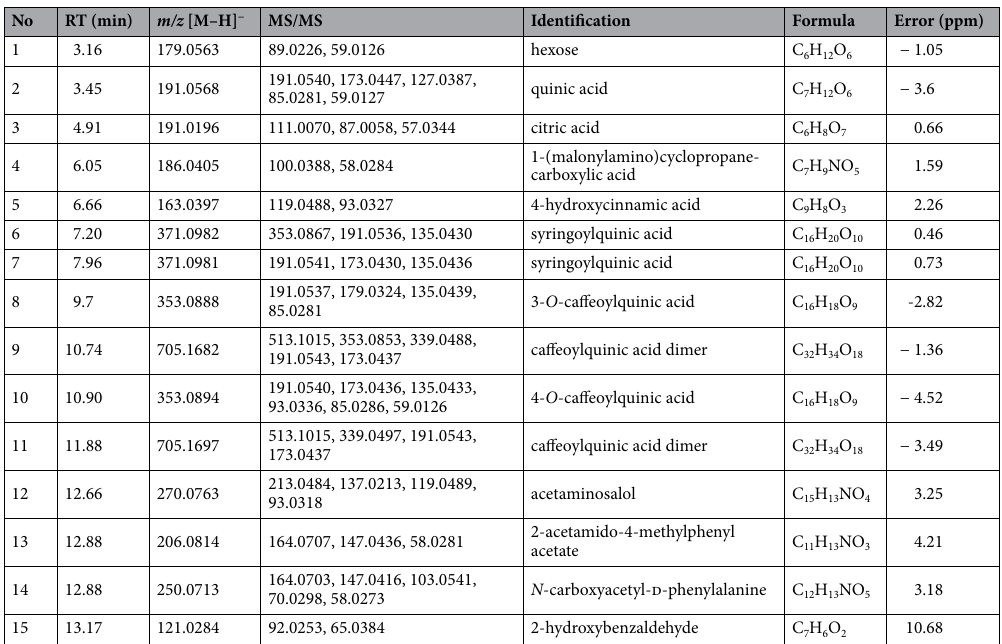
Figure 1. Total ion chromatogram of F. dubia sap extract at a concentration of 20 mg/mL operated in negative ionization mode ( A ) and positive ionization mode ( B ). The peak numbers were referred to the compounds listed in Tables 1 and 2.